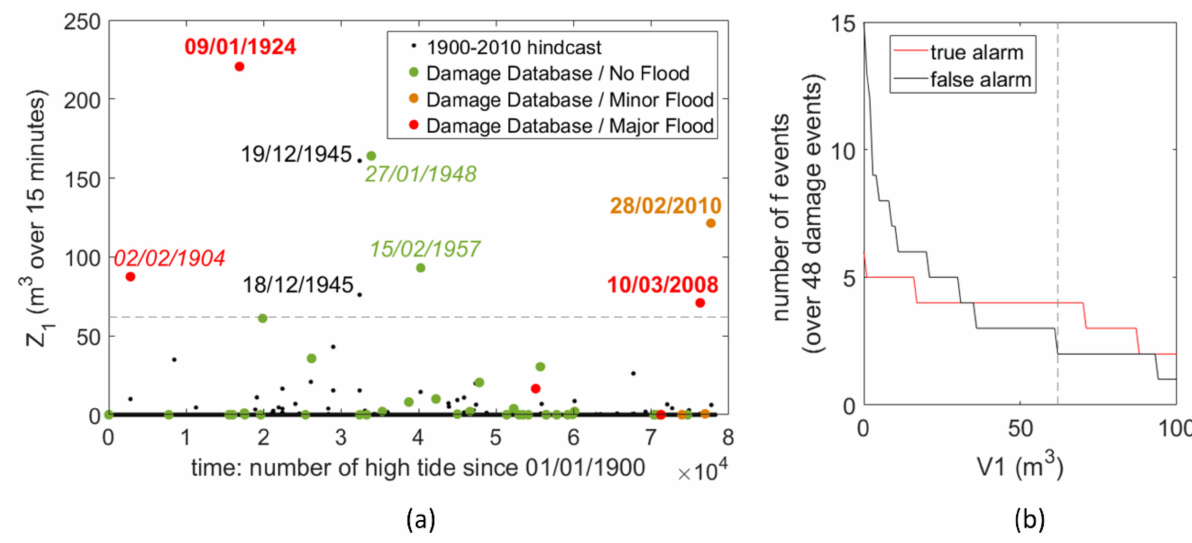
Figure 12. Prediction of Z 1 over the period 1900–2010 ( a ) and the numbers of true and false alarms over the 48 damage database events versus the V1 threshold on Z 1 (b). In ( a , b ), the dashed line indicates the selected threshold after optimisation (V1 = 62 m 3 ). In ( a ), the bolded dates correspond to highly confident information in the damage event database, while italicised dates correspond to moderately confident information in the damage event database, i.e., meaning that there is damage but that we are not fully certain of our classification. In ( b ), a true (false) alarm corresponds to case where Z 1 ≥ V1 (Z 1 < V1) and a (no) historical flood has been